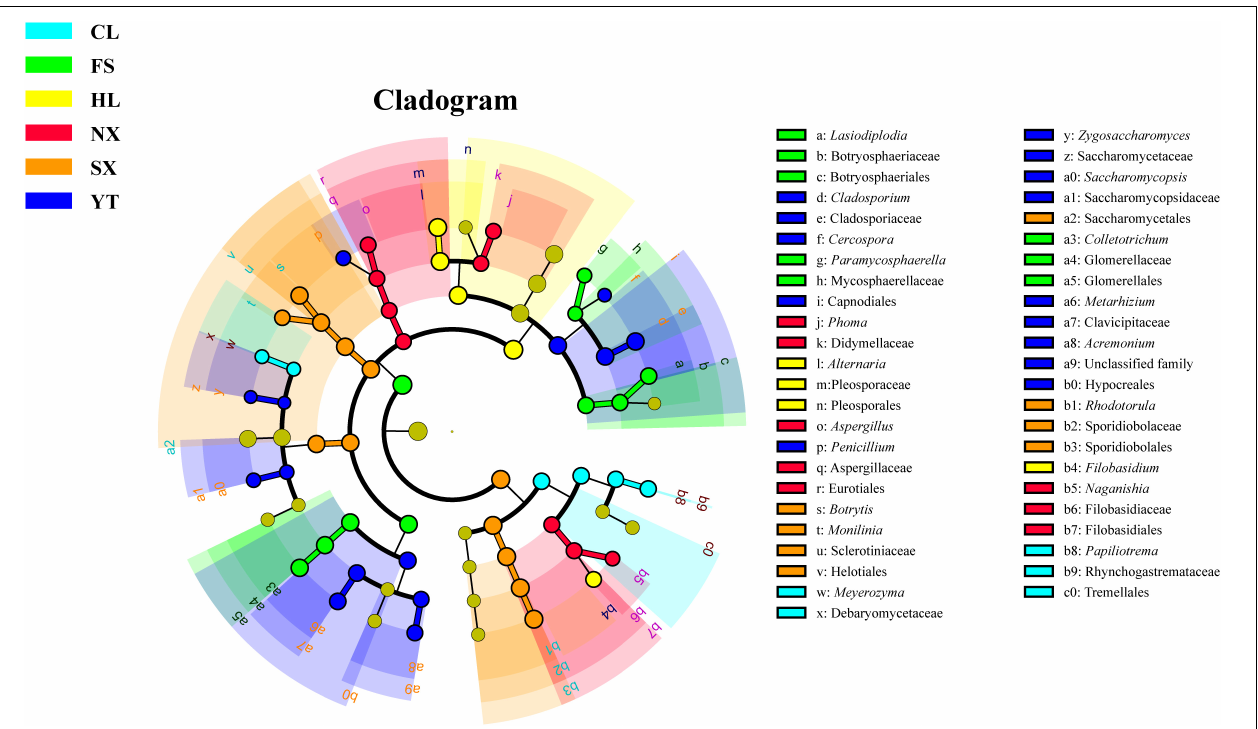
FIGURE 4 | LEfSe results reporting the biomarkers of different regions in the Marselan must fungal communities. TABLE 2 | Climatic and geographic data of the six Marselan regions in 2017 vintage. Region Meteorological station Station Latitude Longitude Average elevation number (0.1